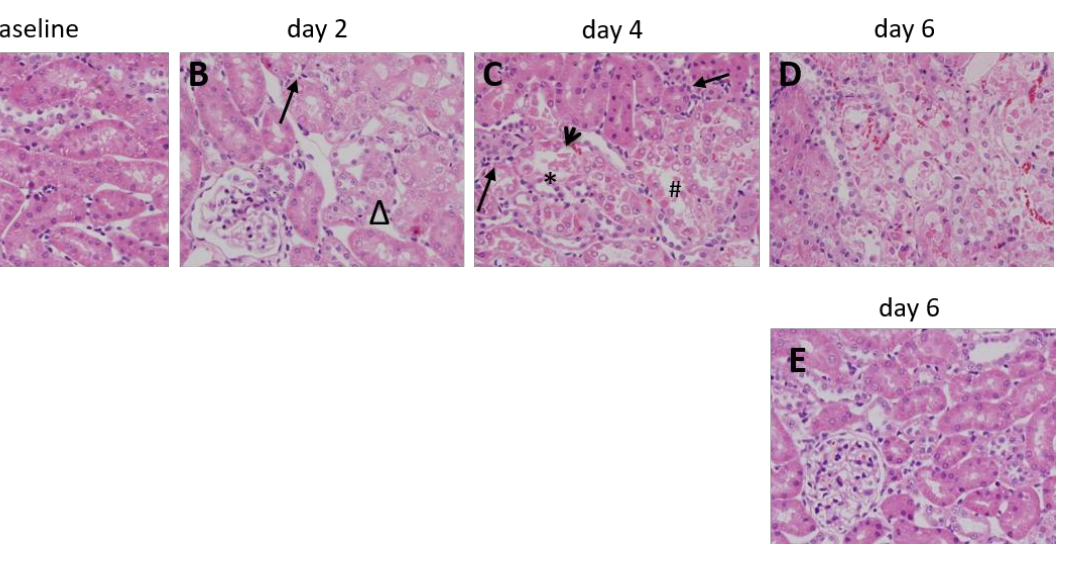
Figure 7. Photomicrographs (magnification, × 400) of hematoxylin – eosin staining reveal renal tissue injuries for the AAN group at baseline ( A ), day 2 ( B ), day 4 ( C ) and day 6 ( D ). At day 2, renal alterations were characterized by vacuolization and swelling of the proximal tubular epithelial cells ( ∆ ). At day 4, tubular necrosis (arrow head), loss of brush borders (*) and fragments of tubular epithelial cells (#) were observed. The above tubular damages became massive and more serious at day 6. No signs of regeneration were observed. Inflammatory cell infiltration was detected (long arrow). No histological changes were found in the control group ( E ).